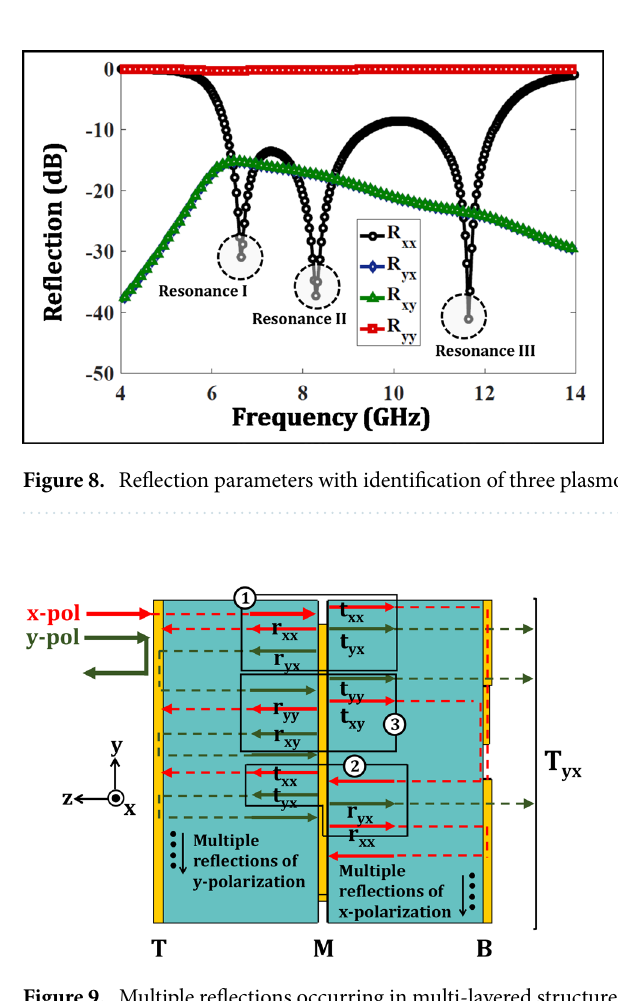
Figure 9. Multiple reflections occurring in multi-layered structure, resembling a Fabry-Perot